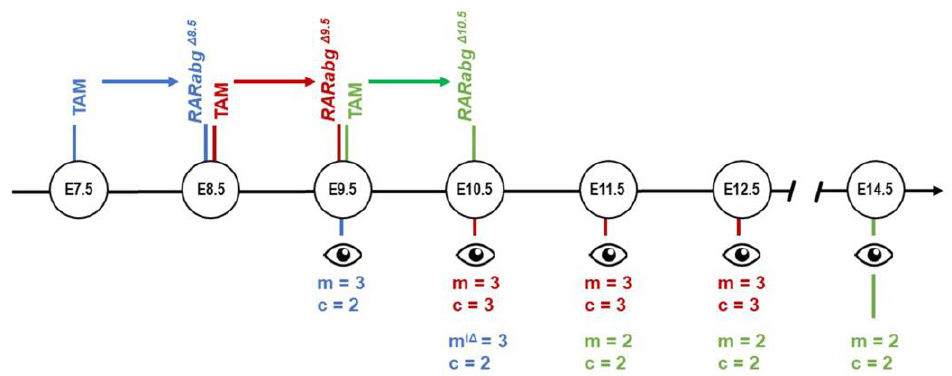
Figure 1. Correspondence between the day of TAM treatment, the time lapse for obtaining mutants with loss of RARA and RARG (colored arrows), the schedule of the phenotypic analyses, and the number of mutants (m) and control (c) embryos examined by HREM at each developmental stage. m i ∆ , these mutants were incompletely excised for Rara and Rarg ; see the main text for further